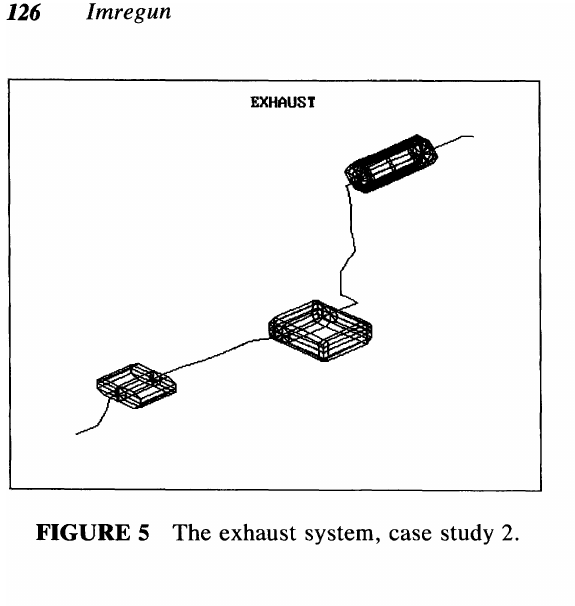
FIGURE 5 The exhaust system, case study 2.